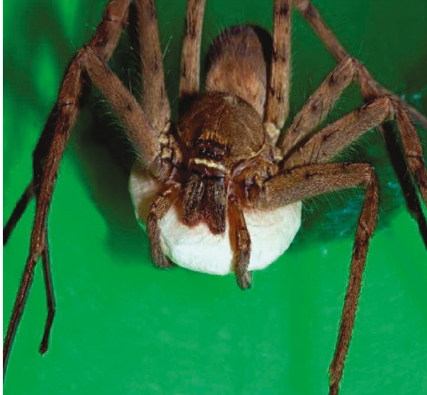
Figure 1: Female Heteropoda venatoria guarding her egg